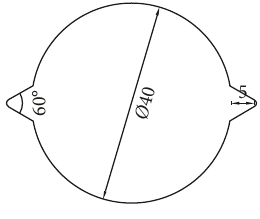
Figure 7: Notch hole size.